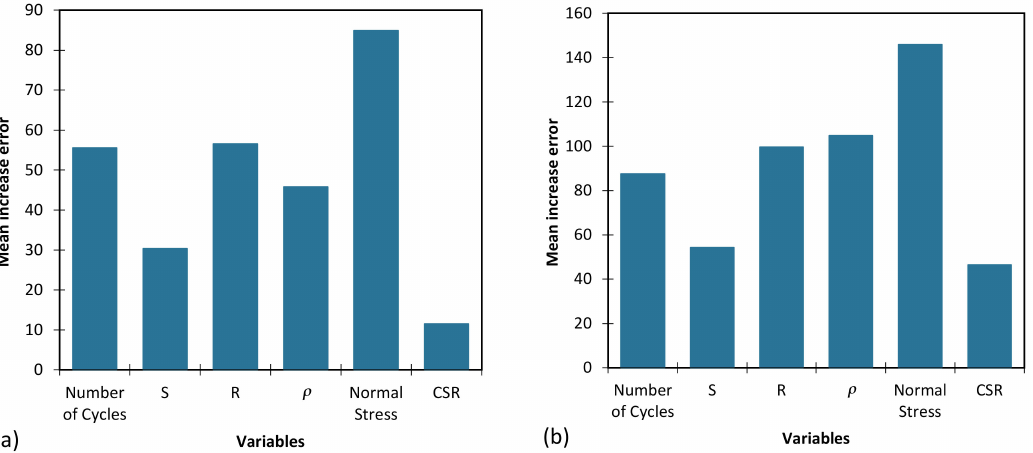
Figure 21. The importance of input parameters on the MAE of the best ( a ) ANN and ( b ) SVM